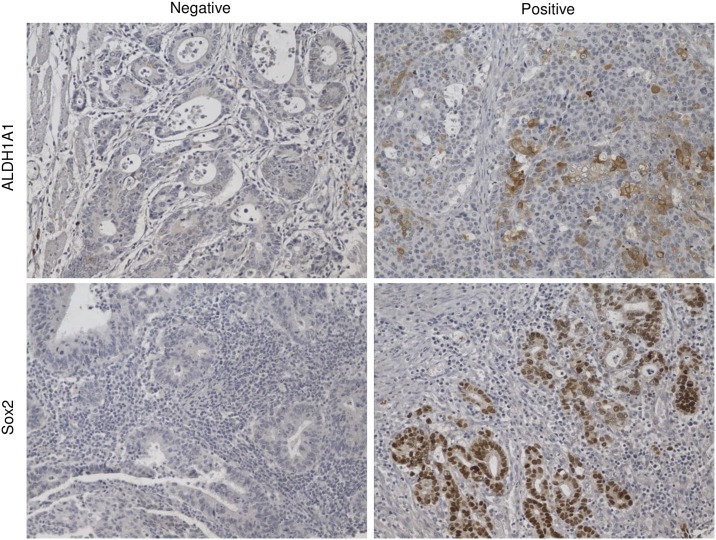
Representative picture of Sox2 and ALDH1A1 expression in gastric cancer.